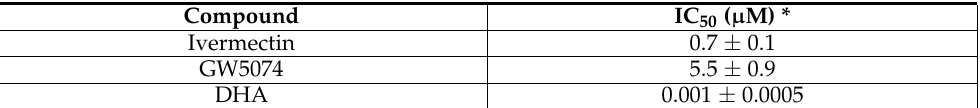
* Results represent the mean ± SD (n = 3) for IC 50 analysis as per Figure 6.